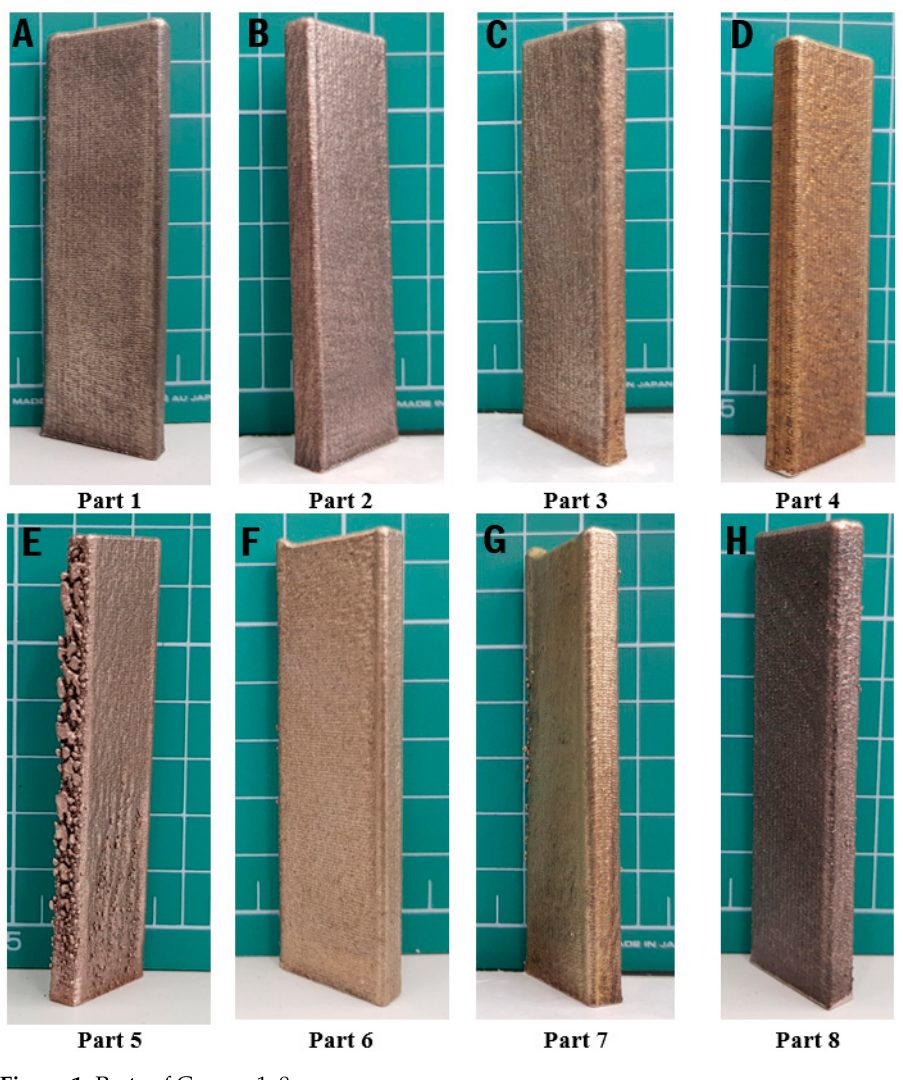
Figure 1. Parts of Groups